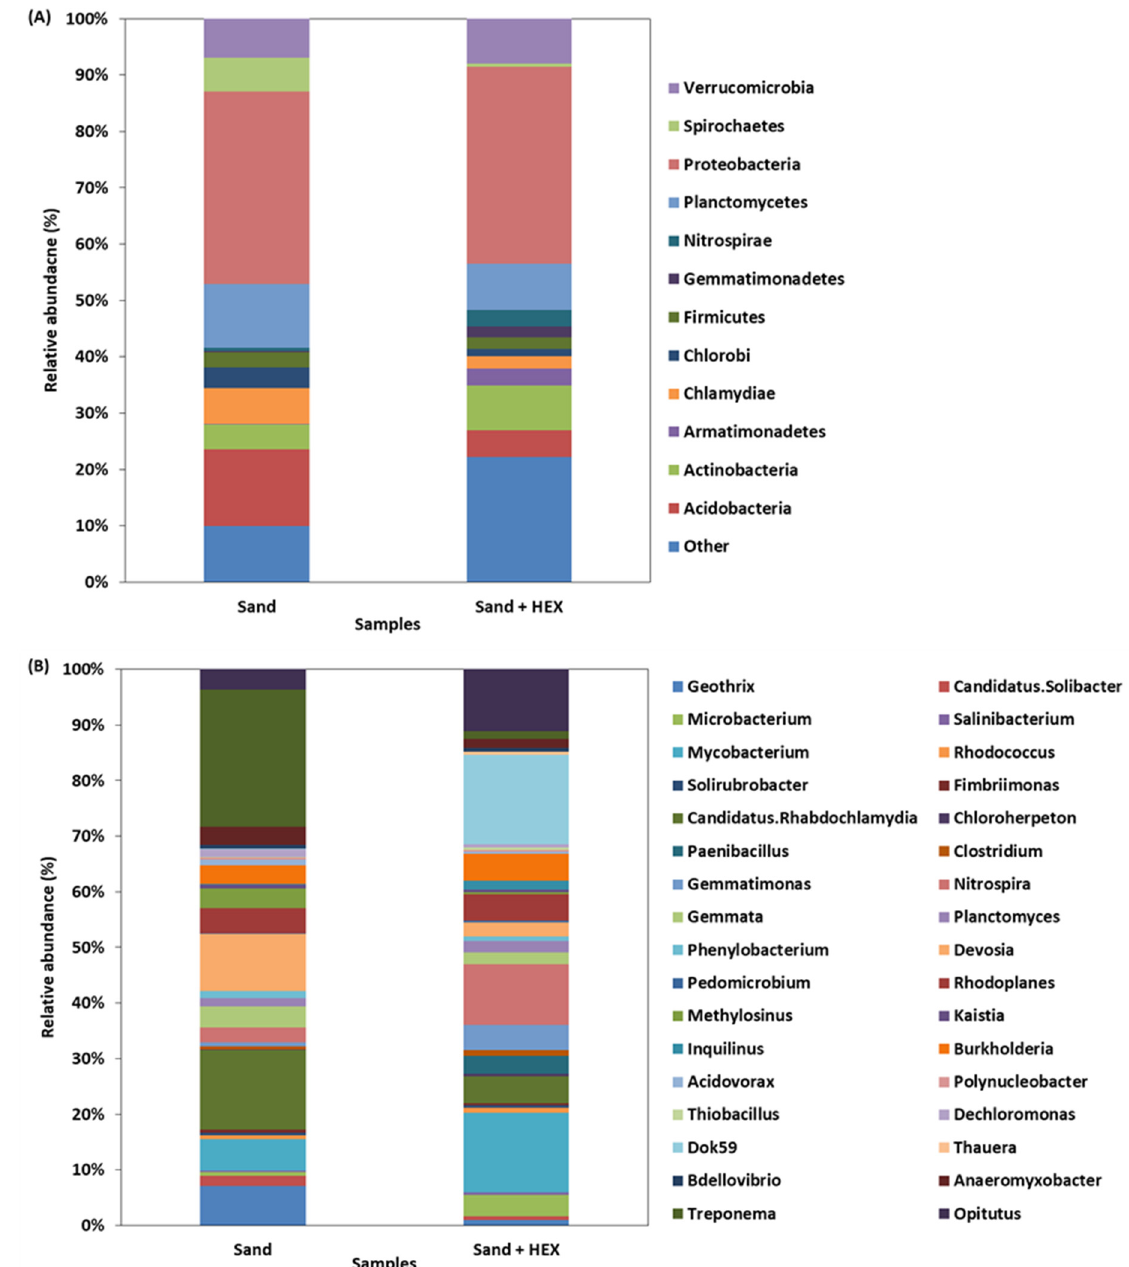
Figure 7. Diversity of the microbial community in the CIE treatment ( A ) phylum and ( B ) genus. It has been reported that the phylum Proteobacteria contains lignin-degrading groups [41]. An additional study reported that Actinobacteria are also lignin-degrading organisms [42,43]. This information supported the performance of lignin–tannin removal in both reactors during this study, where the genera of the Proteobacteria ( Dok59 , Burkholderia , Rhodoplanes , Devosia and Dechloromonas ) and the Actinobacteria ( Microbacterium , Salinibacterium , Mycobacterium , Rhodococcus and Solirubrobacter ) were responsible for the degradation. In addition, the presence of the genus Nitrospira in the DM-BR increased the removal of NH 4+ -N compared to the C-BR. This genus has previously been shown to perform well in the oxidation of NH 4+ -N [44,45].